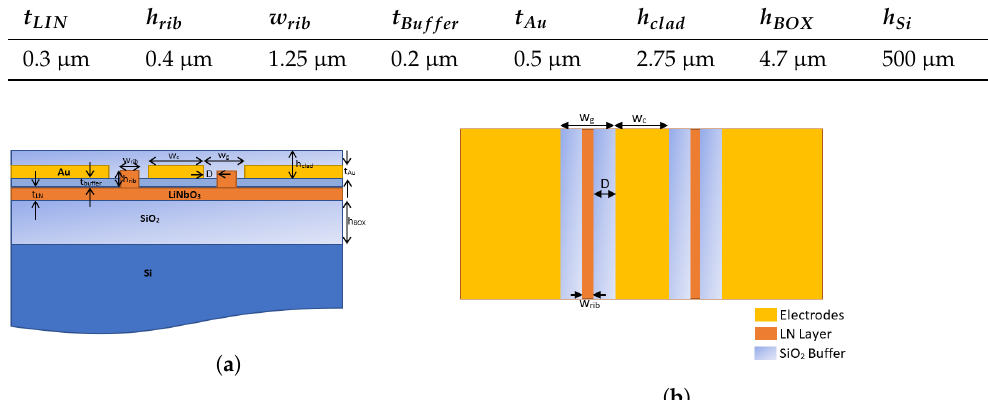
Figure 1. ( a ) Cross section and ( b ) top view of the proposed electro-optic modulator.